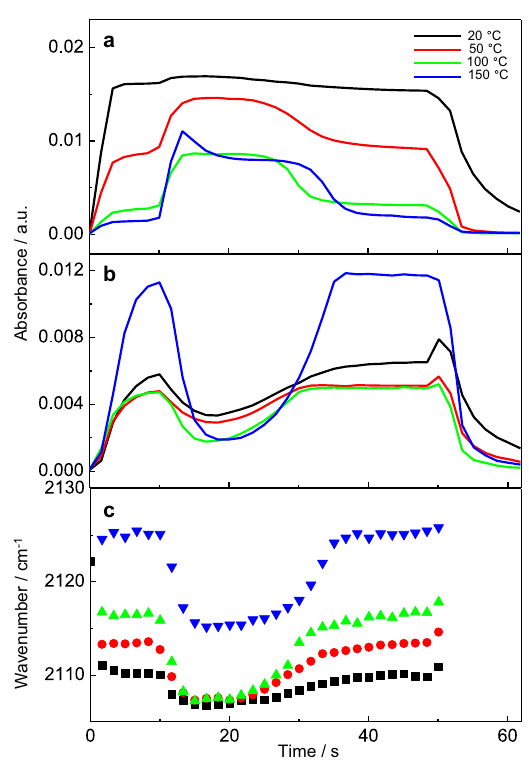
Fig.3|VariationoftheIRintensityandwavenumberofCO-AuandCO 2 against time during CO oxidation at different temperatures. a Variation of the IR intensity of CO-Au against time; b variation of the IR intensity of CO 2 against time; c plots of the position of CO band against time at different temperatures. The signals were corrected by subtracting the broad background signal. Experimental conditions:reactiongascompositionis1%COand1%O 2 balancedwithHe; fl owrate is 30mLmin − 1 ; modulation period is 100s; number of spectra in one cycle is 60; during the fi rst half-cycle 1% CO and 1% O 2 in He was fl owed through the cell, then the feed gas was switched to He for the second